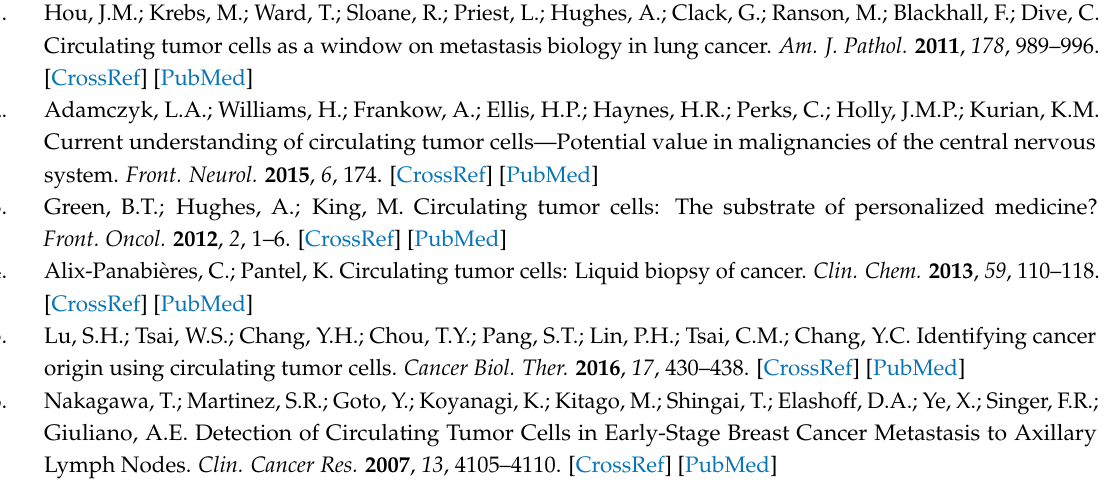
Figure S1: Number of TCs and WBCs counts through flow cytometry (Z2-Beckmann Coulter Counter) of six cell samples (200 µ L-volume) extracted through the two outlets of the Locust-chip after their ultrasonic processing ( f = 952 kHz, V = 28 V) at a flow rate of Q = 80 µ L/min. Acknowledgments: This work was partially supported by the Ministry of Economy and Competence of Spain (MINECO) under two projects: BIO2011-30535-C04-01: Development of a high-throughput ultrasonic technology for the isolation of circulating tumor cells from peripheral blood samples; and DPI2017-90147-R: Low intensity a Low Intensity ultrasounds for early diagnosis and modulation of tumor and